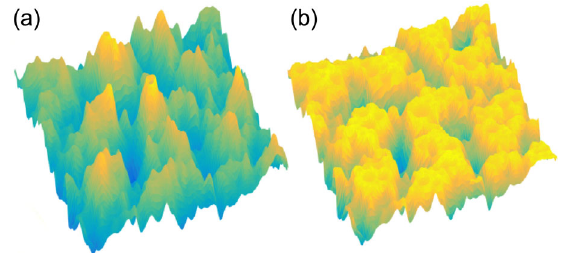
Fig. 7 Illustration of a rough surface (a) and its worn state (b) according to the rules described in Sec. 4.1. It was generated using the following parameters: